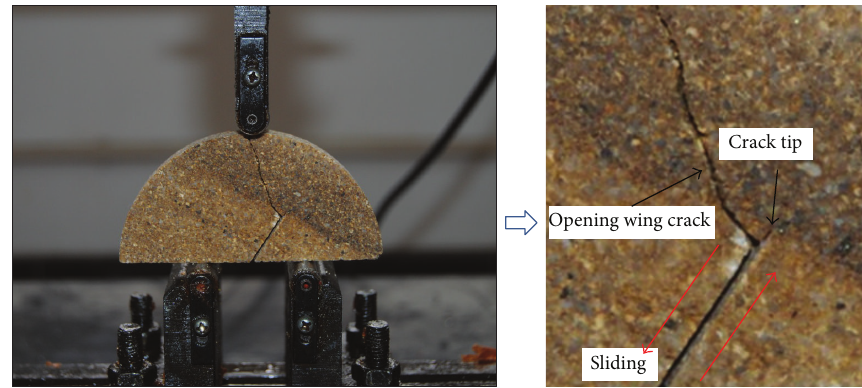
Figure 3: Typical broken SCB specimen and the failure pattern of compression-induced